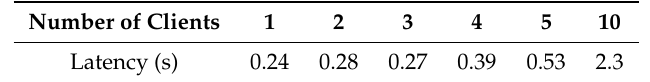
Table 2. Test results for Configuration 2: Video players in the same web